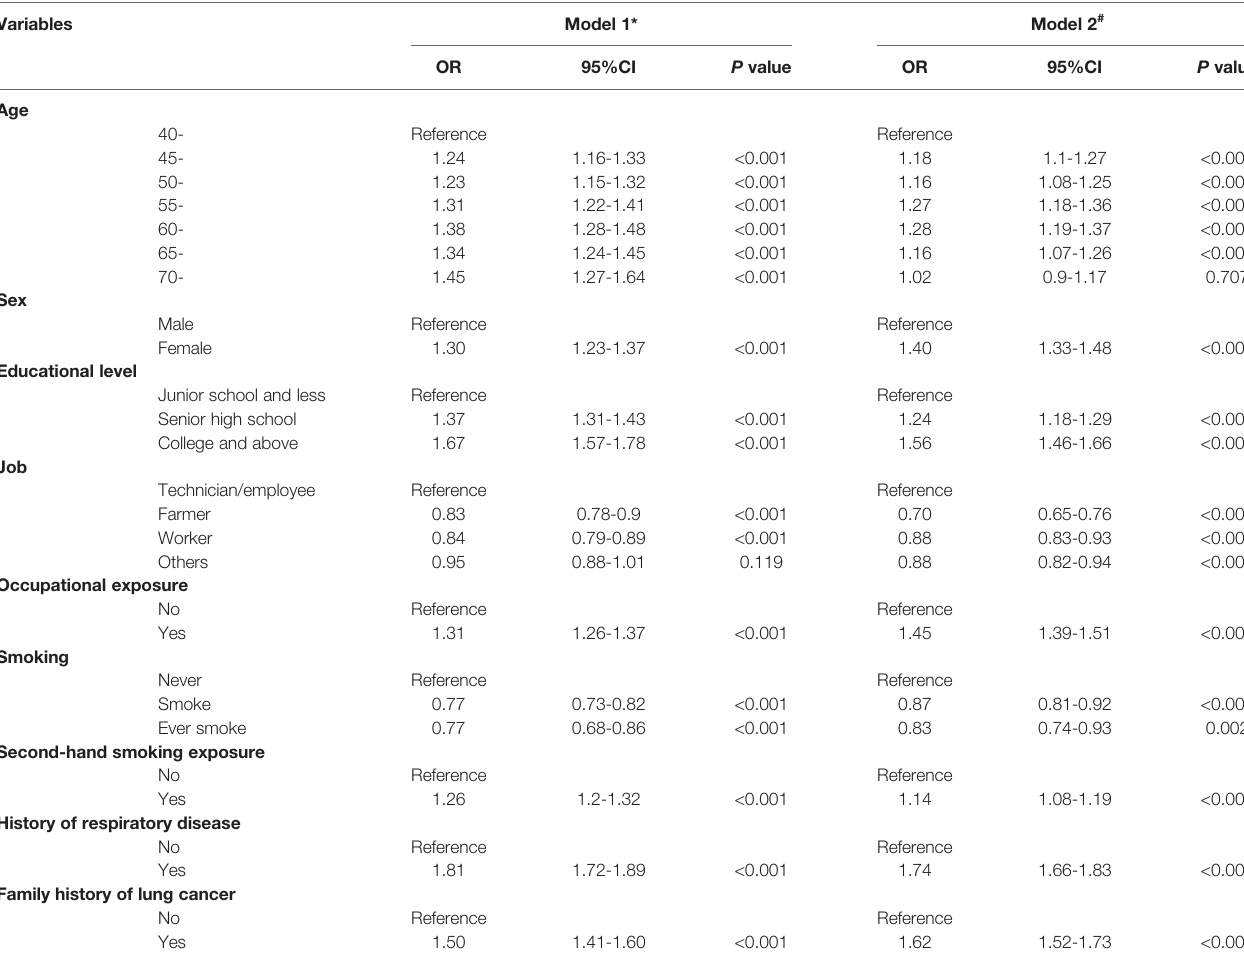
TABLE 2 | Factors associated with participation rate in lung cancer